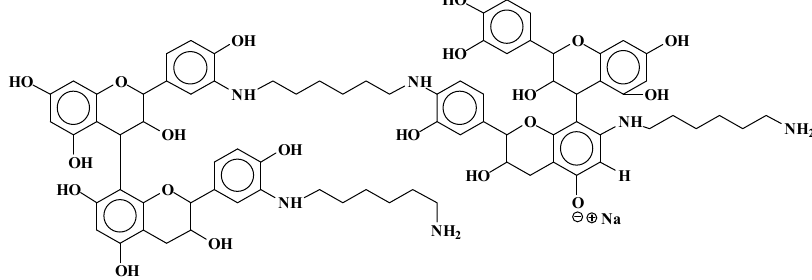
Figure 15. Example of two flavonoid dimers covalently bridged by a diamine with other covalently linked diamines at 1459 Da.